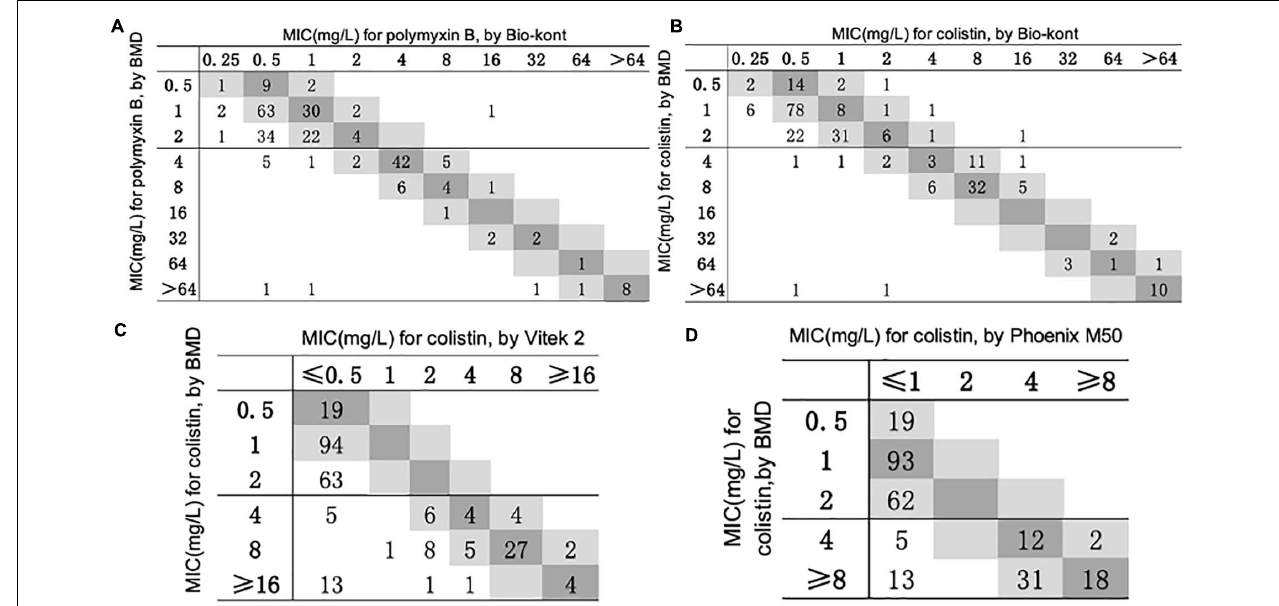
FIGURE 1 | Scatterplot of three AST methods versus reference MIC obtained from BMD. The BMD MICs have been normalized in the scatterplots of Phoenix M50 and Vitek 2. When compared with Vitek 2, the maximum test limit is ≥ 16 mg/L, while compared with Phoenix M50, it is ≥ 8mg/L. (A) Scatterplot of Bio-kont versus